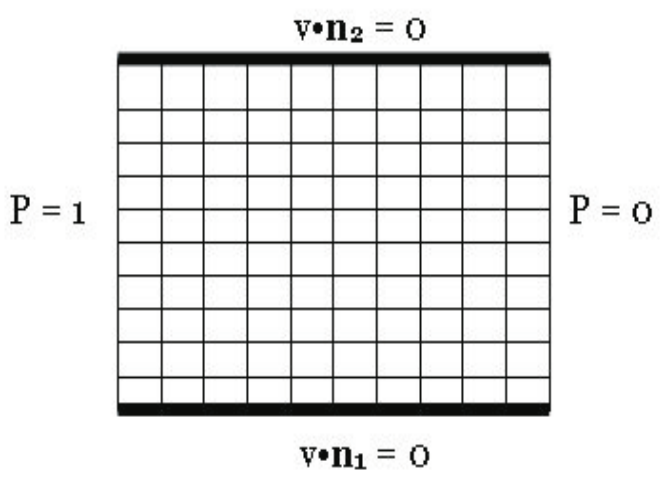
Figure 2. Fine scale permeability upscaling with no-flow boundary